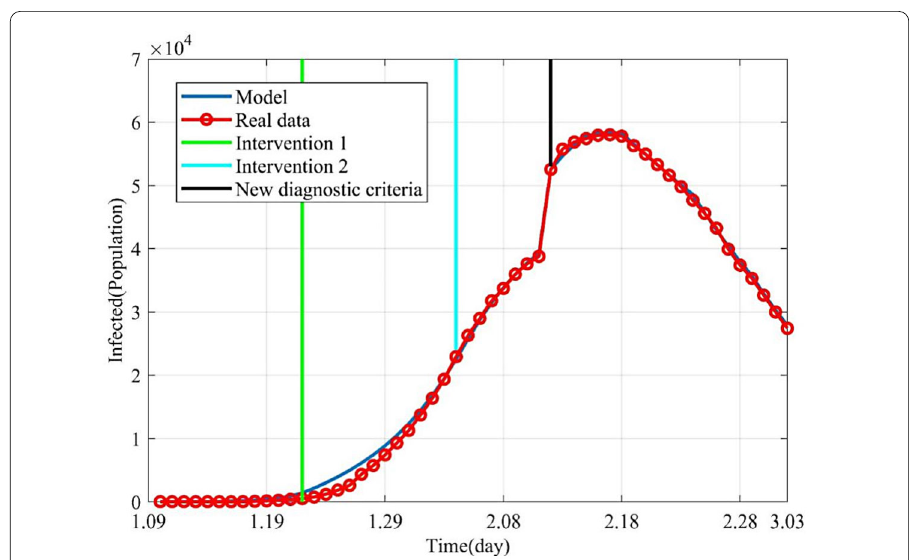
Figure 4 Dynamic trends of the infected. The blue line represents the simulation of SEIR model. The red line represents the data issued by NHCC. The green line represents the intervention 1. The light blue line represents the intervention 2. The black line represents that the government began to implement new diagnostic criteria